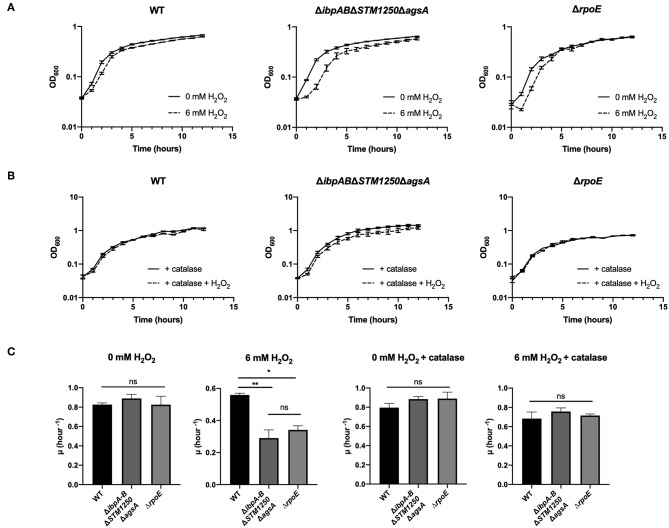
The quadruple deletion mutant is more sensitive to 6 mM H2O2 compared to WT. Bacteria were grown in a plate reader for 12 h at 37°C. (A) Bacteria grown either with or without 6 mM H2O2. OD600 readings taken hourly. (B) Bacteria grown in the presence of 1,000–4,000 U/mL bovine catalase and either with or without 6 mM H2O2. OD600 readings taken hourly. (C) Initial growth rate constants for bacterial growth in the presence/absence of 6 mM H2O2 and/or 1,000–4,000 U/mL bovine catalase. Data are the means of three separate experiments performed in duplicate. Error bars show SEM. Data analyzed by one-way ANOVA with Tukey's multiple comparisons test, ns p > 0.05, *p < 0.05 and **p < 0.005 vs. WT.